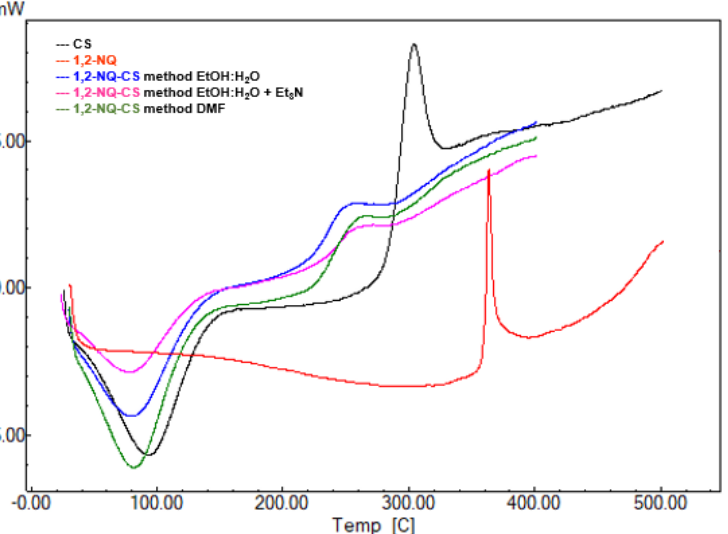
Figure 8. DSC thermograms of sodium 1,2-naphthoquinone-4-sulfonate (1,2-NQ), chitosan (CS), 1,2- NQ-CS obtained by the EtOH:H 2 O method, 1,2-NQ-CS following the EtOH:H 2 O + Et 3 N method and 1,2-NQ-CS following the DMF method.